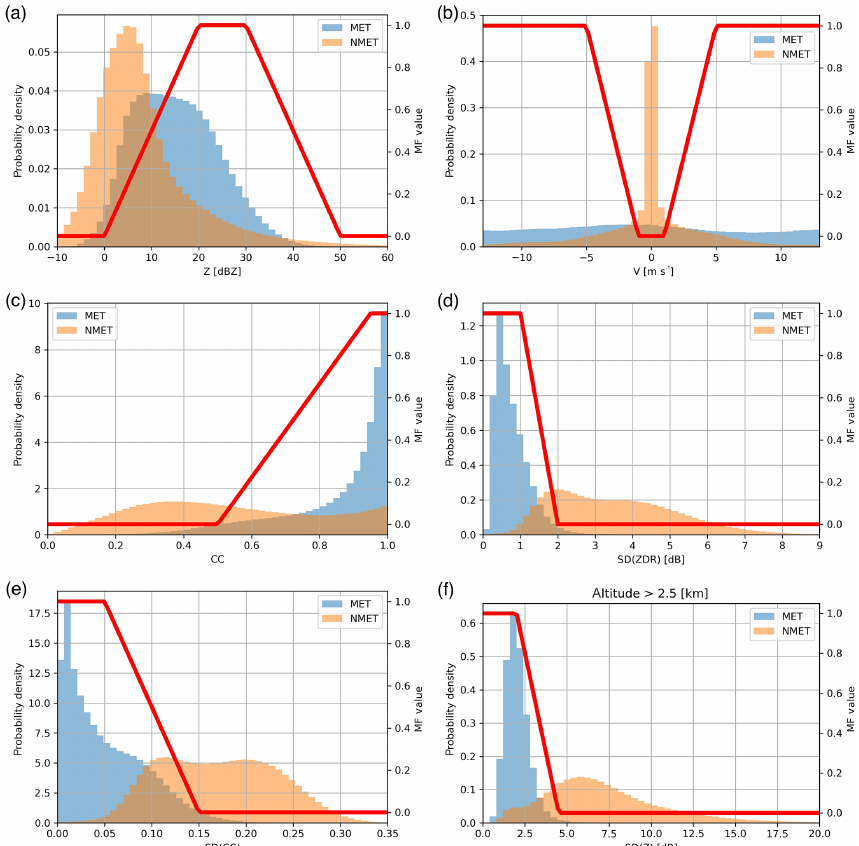
Figure 2. The normalized frequency distributions and membership functions of features: (a) Z , (b) V , (c) CC, (d) SD(ZDR), (e) SD(CC), and (f) SD( Z ) (in the regions over 2.5km in